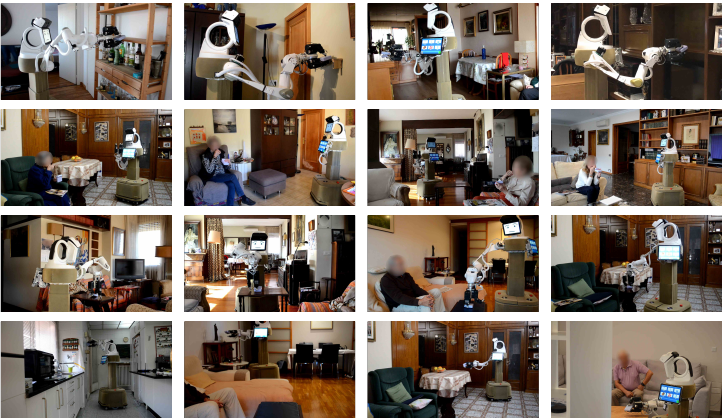
Figure 14. Selected cases of execution of the medication assistance scenario in 12 different real house environments.The instances concern RAMCIP robot during “pill box” grasping from high shelf ( first row ), activity monitoring ( second row ), “pill box” grasping from table ( third row ) and “pill box” release to its storage position ( last row ).